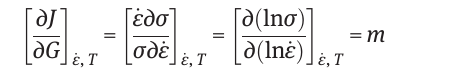
Figure 6. It can be seen that m -values vary violently with the variation of temperatures, strains and strain rates, which indicates that microscopic deformation mechanism has been changed greatly. From Table 1, it can be noticed that negative m -values appear under the following conditions: strain of 0.05 – 0.15, temperature of 773 K and strain rate of 10 s – 1 ; strain of 0.05 – 0.15, tem- perature of 1,123 K, strain rate of 0.01 and 10 s – 1 ; strain of